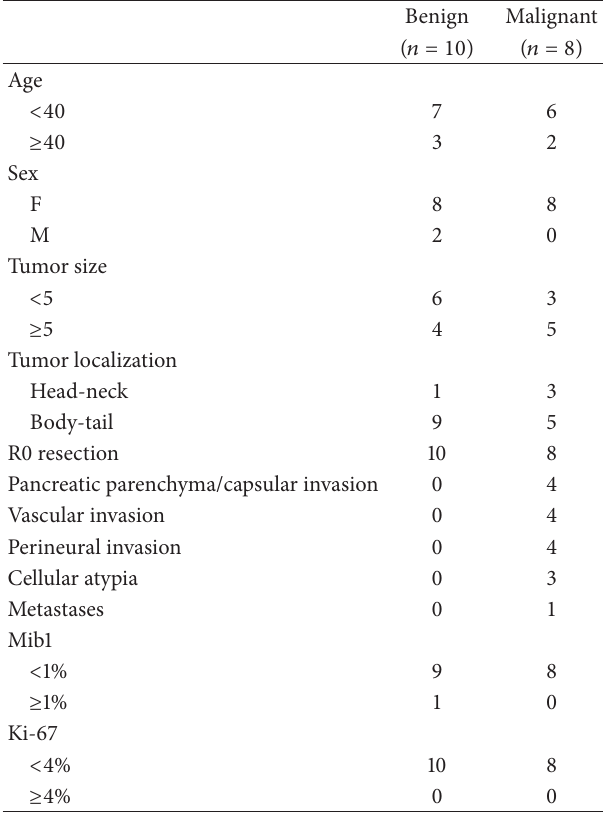
mucinous tumor ( 𝑛 = 2 ), and SPT ( 𝑛 = 14 ). Twelve Table 2: Clinicopathological features of Benign and Malignant